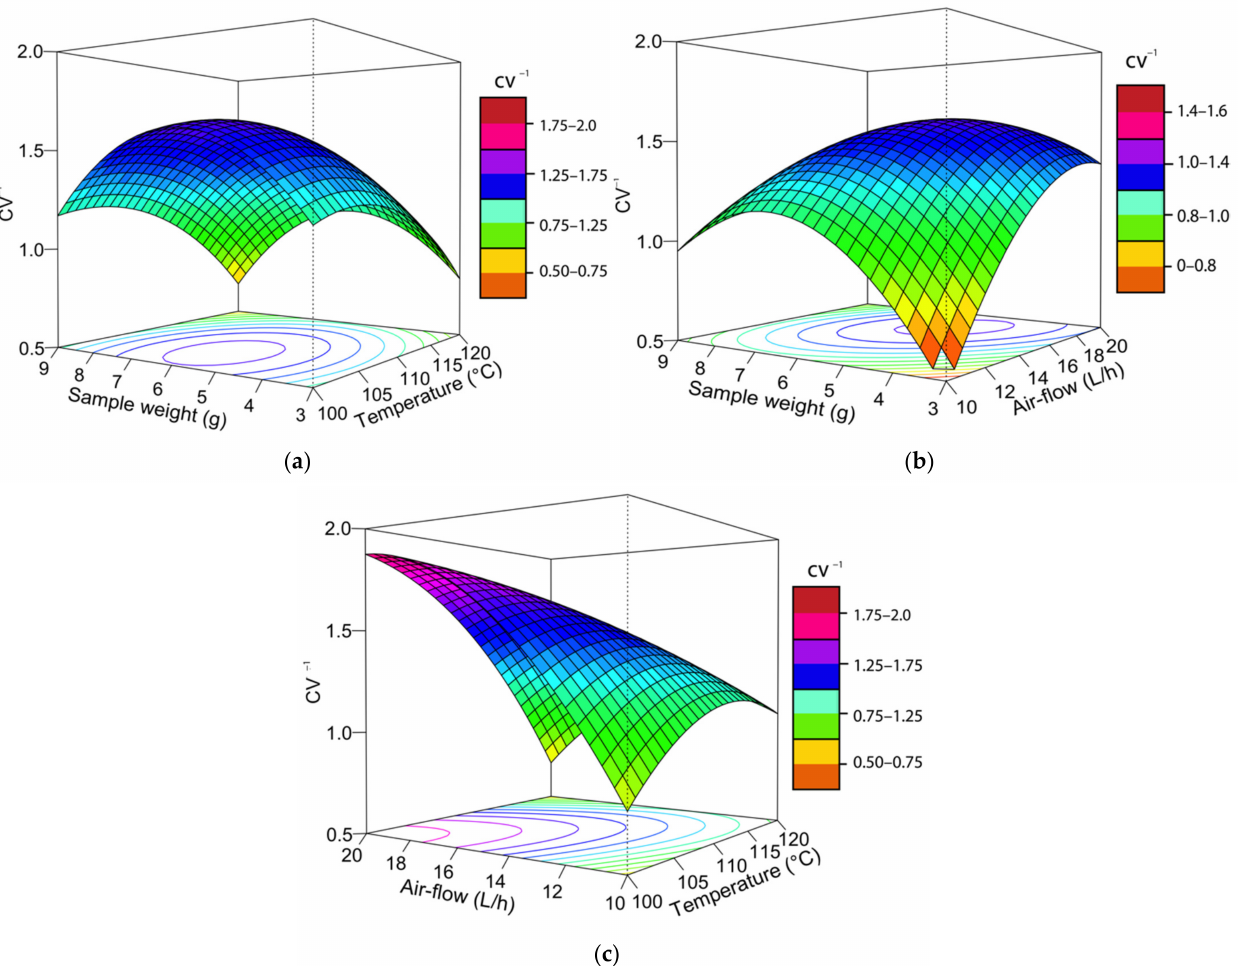
Figure 2. Surface and contour plots for the inverse of the coefficient of variation ( CV − 1 ) versus ( a ) sample weight (g) and temperature ( ◦ C); ( b ) sample weight (g) and airflow (L · h − 1 ); and ( c ) airflow (L · h − 1 ) and temperature ( ◦